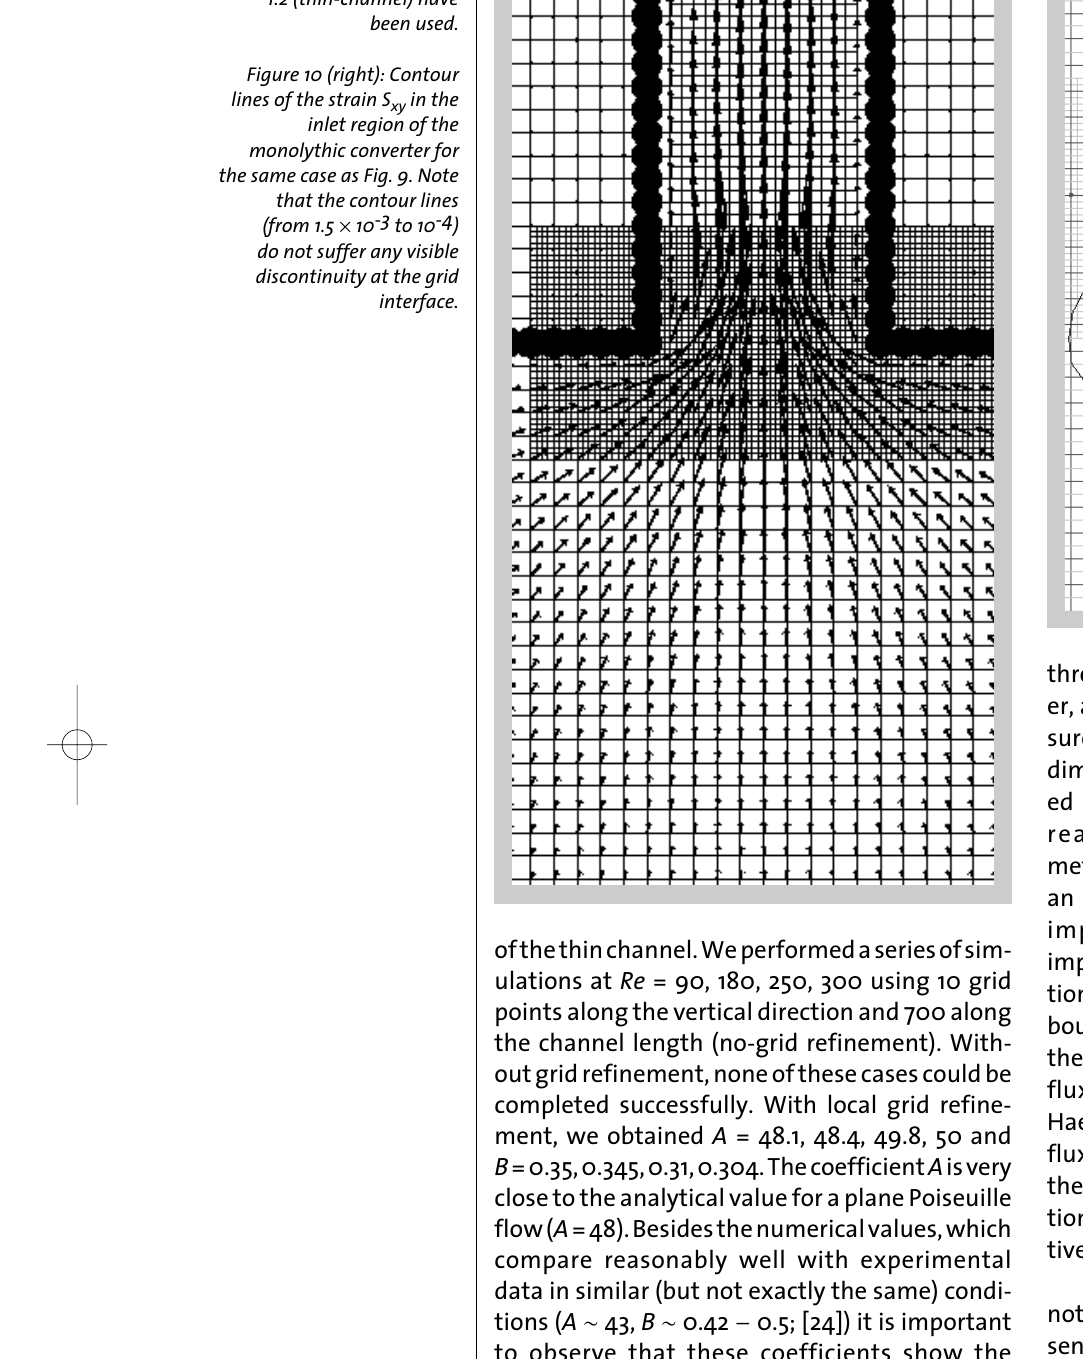
Figure 10 (right): Contour lines of the strain S xy in the inlet region of the monolythic converter for the same case as Fig. 9. Note that the contour lines (from 1.5 ¥ 10-3 to 10-4) do not suffer any visible discontinuity at the grid